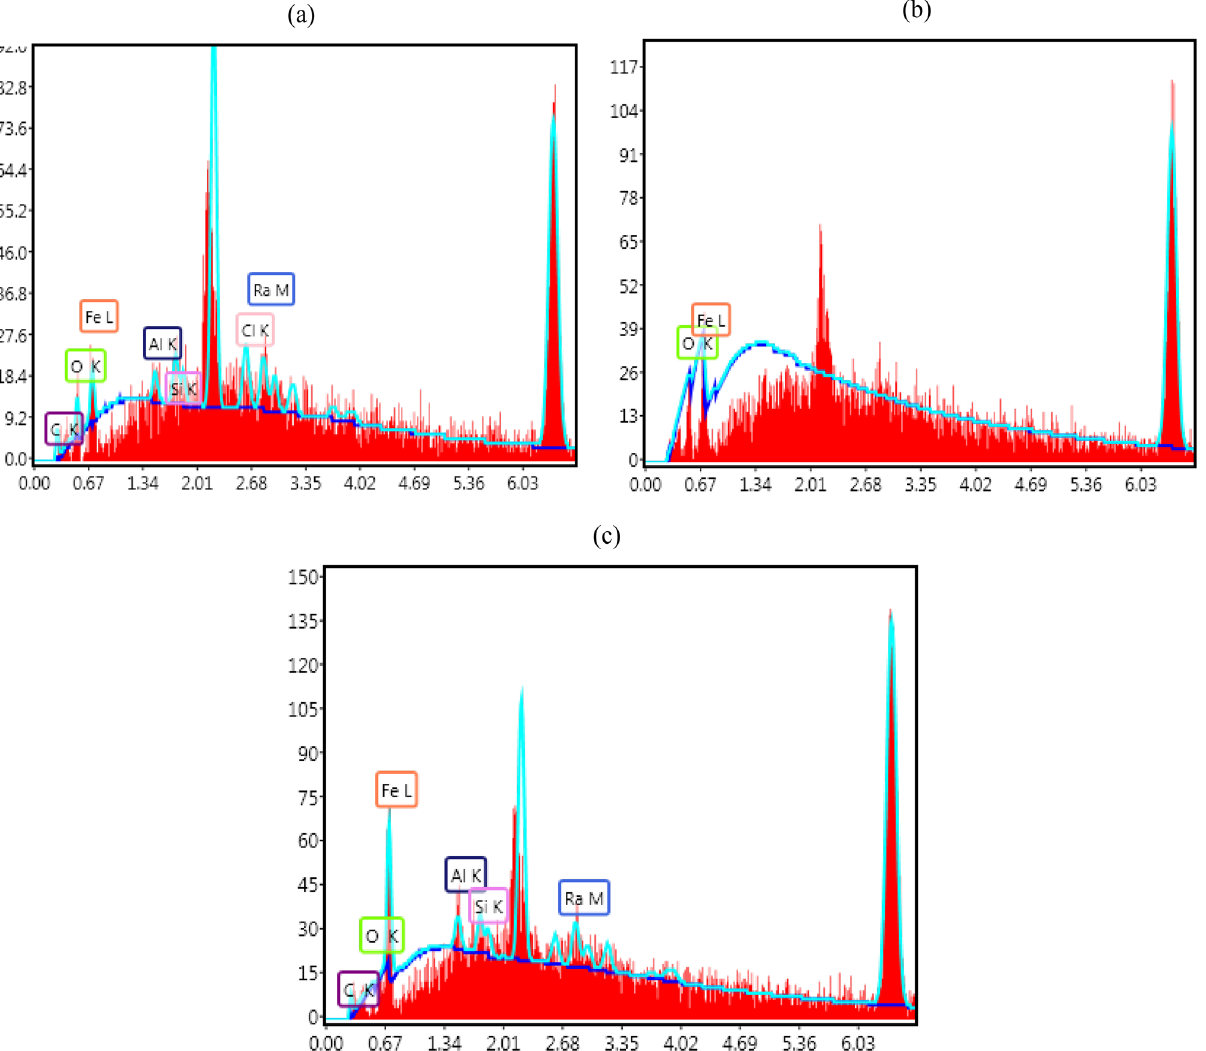
Figure 5. ( a ) Spectrum of mild steel in 0.1 M HCl ( b ) Spectrum of mild steel in 0.1 M HCl inhibited L1 Schiff base, ( c ) Spectrum of mild steel in 0.1 M HCl inhibited L2 Schiff